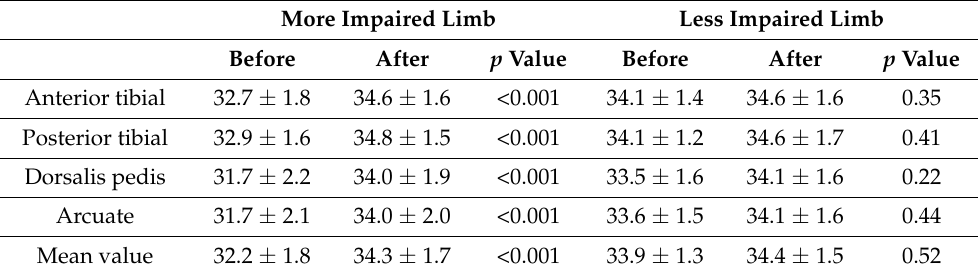
Values are expressed as ◦ C.